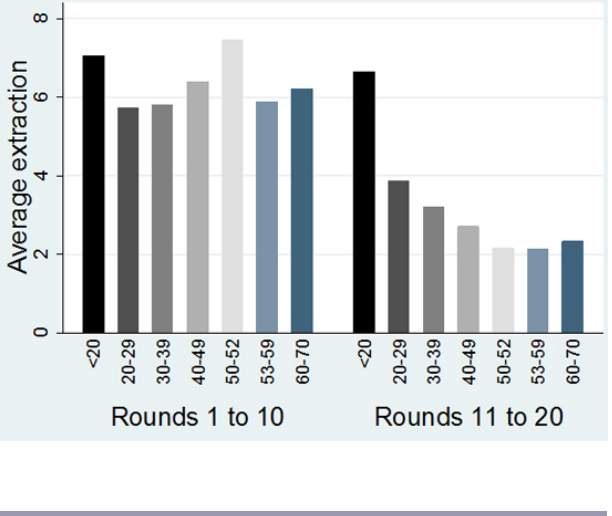
Fig. 2 . Age average